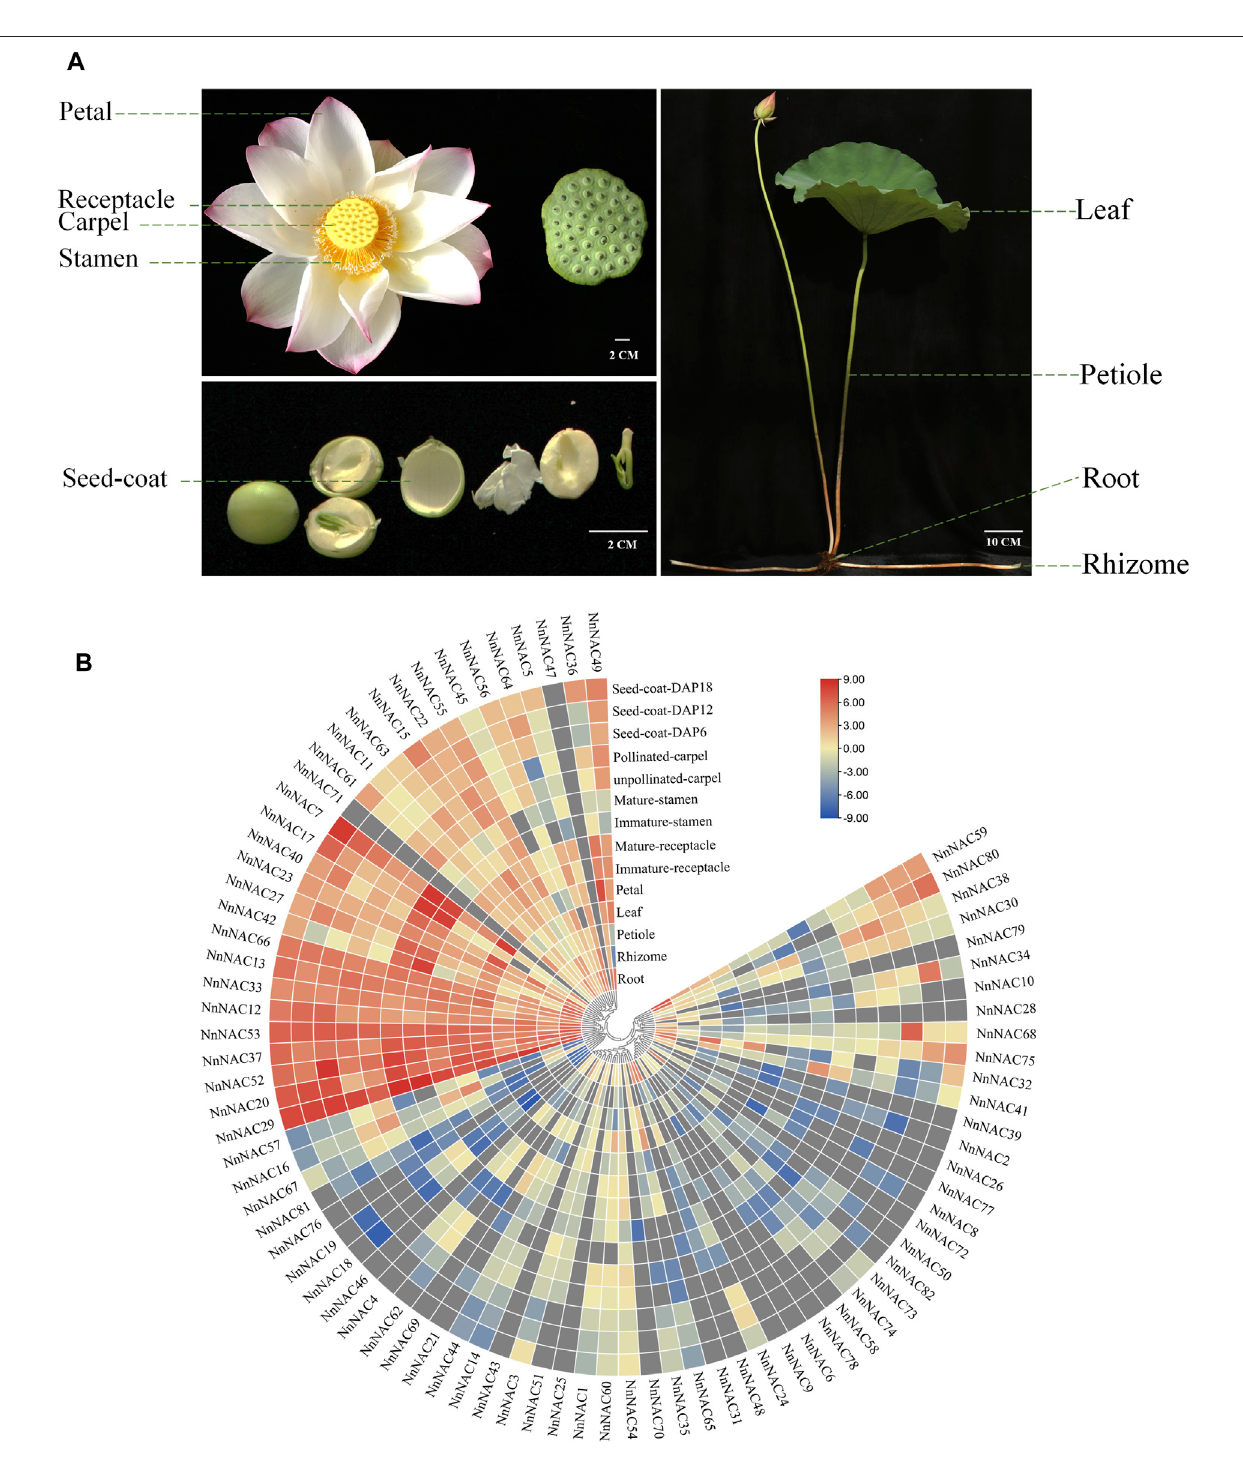
FIGURE 5 | Expression pro fi ling of NnNAC genes in different lotus tissues. (A) Lotus tissues used to analyze the expression of NnNAC genes. (B) Heat-map clustering based on FPKM expression of 82 NnNAC genes in different lotus tissues.